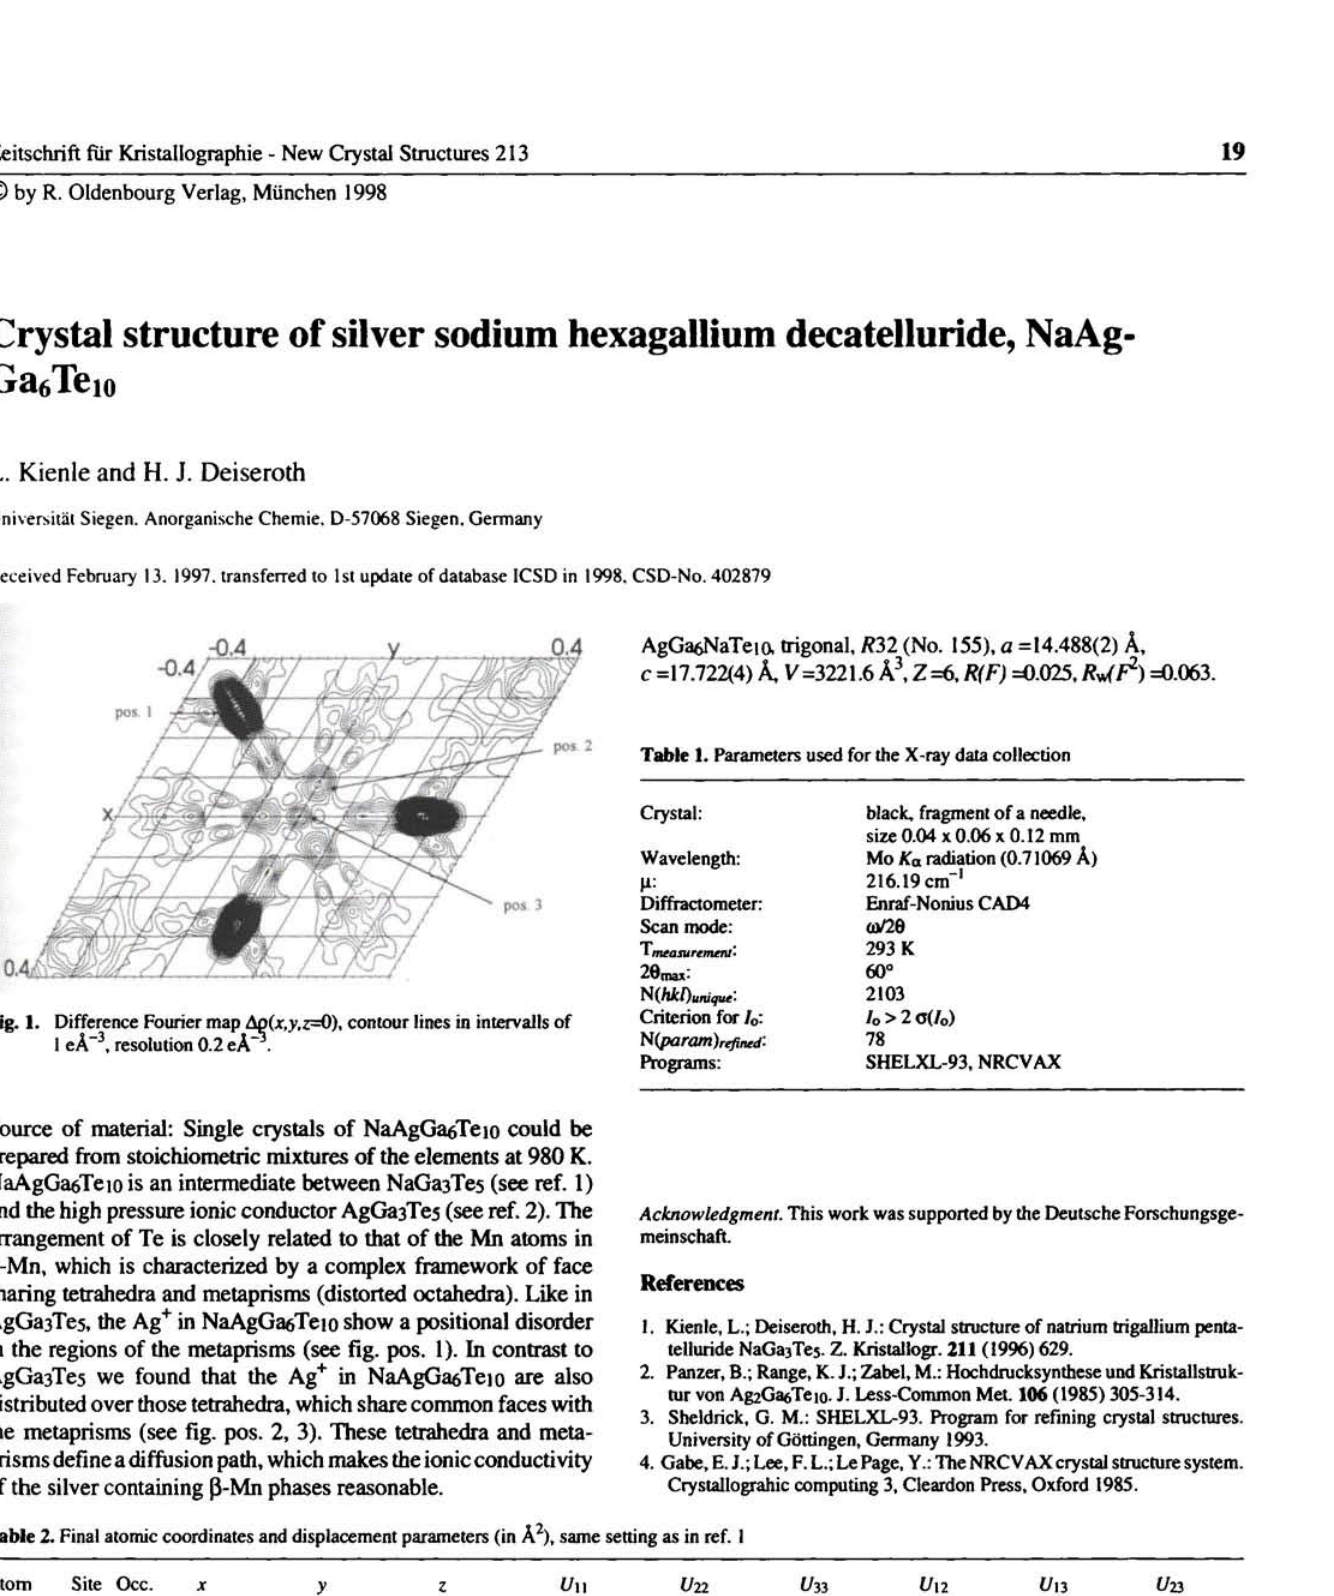
Table 2. Final atomic coordinates and displacement parameters (in Â^), same setting as in ref. I Atom Site